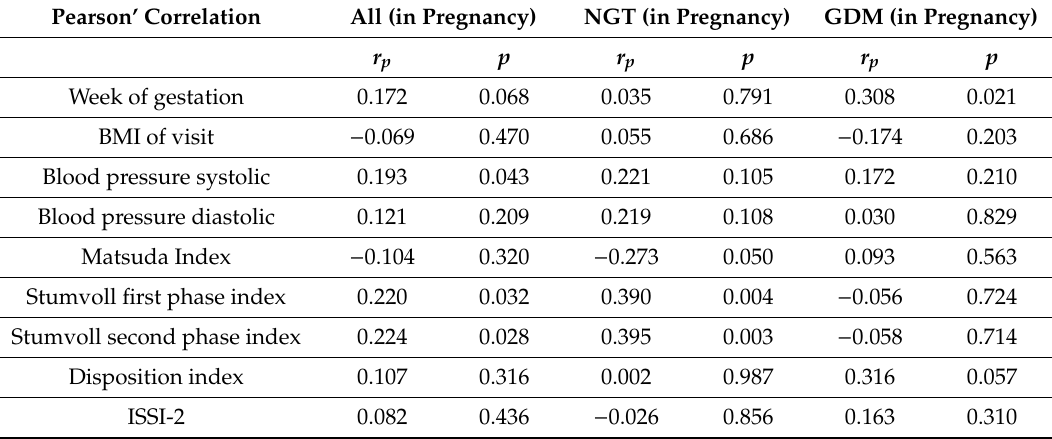
Figure 2. Grouped scatter dot plot according to glucose tolerance (blue = NGT, red = GDM) of the correlation between secretagogin (SCGN) (log-transformed) and Stumvoll first phase index during pregnancy. SCGN correlated directly with Stumvoll first phase index in women with NGT ( r p = 0.390, p = 0.004), an effect which was not present in GDM ( r p = − 0.056, p = 0.724). NGT: normal glucose tolerance; GDM: gestational diabetes mellitus. Table 2. Pearson’s correlation analysis SCGN during pregnancy in all women, women with NGT and GDM. The significance level is p ≤